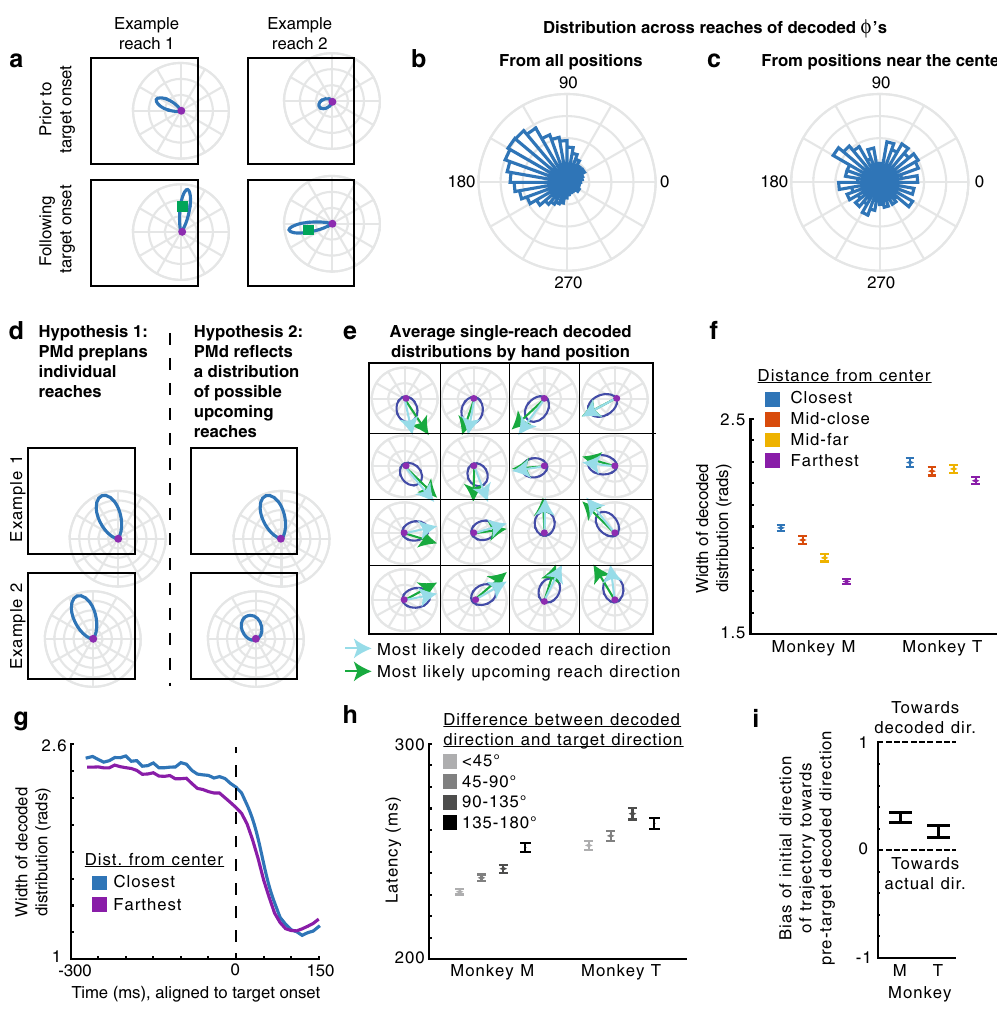
Fig. 5 PMd population activity represents the distribution of upcoming movements — single reach decoding. a The distribution of decoded reach directions (blue) from the population of PMd neurons for two example reaches (left and right), before and after target onset (top and bottom). The purple circle is the current hand position, and the green square is the target location. b The distribution of decoded Φ ’ s across all reaches. The decoded Φ is the pre-target decoded reach direction relative to the hand ’ s angular position (same as Φ from Fig. 1, except with decoded direction instead of actual reach direction). c The distribution of decoded Φ ’ s across reaches starting within 2 cm of the center. d The predictions of two hypotheses (left and right), shown for two different hand positions (example 1 vs. example 2). e Average pre-target decoded reach direction distributions as a function of hand position. The displayed distributions have the average width and peak angle of all decoded distributions from hand positions within the grid square. Light blue arrows point toward the circular means of these distributions. Green arrows point toward the most likely reach direction (from Fig. 1d). f The full width at half maximum of the pre-target decoded distribution as a function of hand distance from the center of the workspace. Distances from the center are binned as in Fig. 2. Error bars are SEMs. g Width of the decoded distributions over time, for starting positions that are closest (blue) and farthest (purple) from the center. h Latency of the reach as a function of the angular difference between the pre-target decoded direction and the actual target direction. Error bars are SEMs. i The bias of the initial trajectory of the reach (100 – 150 ms from target onset) toward the pre-target decoded direction. A bias of 1 signi fi es the initial trajectory is toward the decoded direction, while a bias of 0 is toward the actual target direction. Negative values are away from the decoded direction. 95% con fi dence intervals, computed via bootstrapping, are